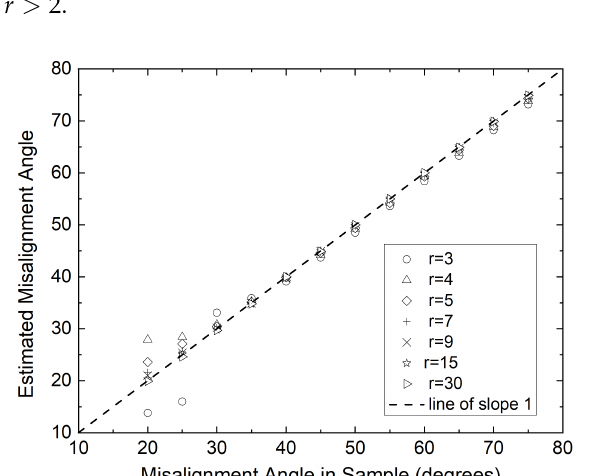
Figure 10. Parity graph between misalignment angle in the actual sample (in degrees, horizontal axis) and the back-calculated (cid:101) obtained by solving Equation (10) in which H av and r are known (vertical axis). Data points indicate results from samples at various values of r , as indicated, and for the (cid:101) corresponding to the horizontal axis. Data points falling close to the line of slope one (shown) indicate reliable algorithm predictions. In all cases, sample size M ∼ 10 4